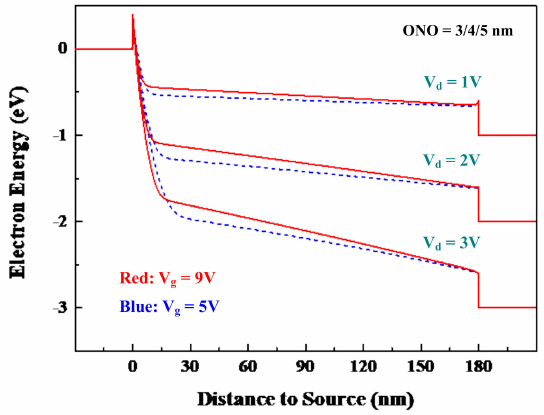
Figure 9. Conduction band diagrams of scaled double-gate Schottky barrier charge-trapping cells along the channel surface at various gate and drain